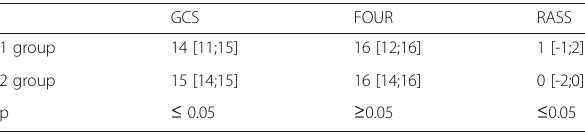
Table 1 (abstract 000359). Level of consciousness, the presence of sedation/agitation, Me [25;